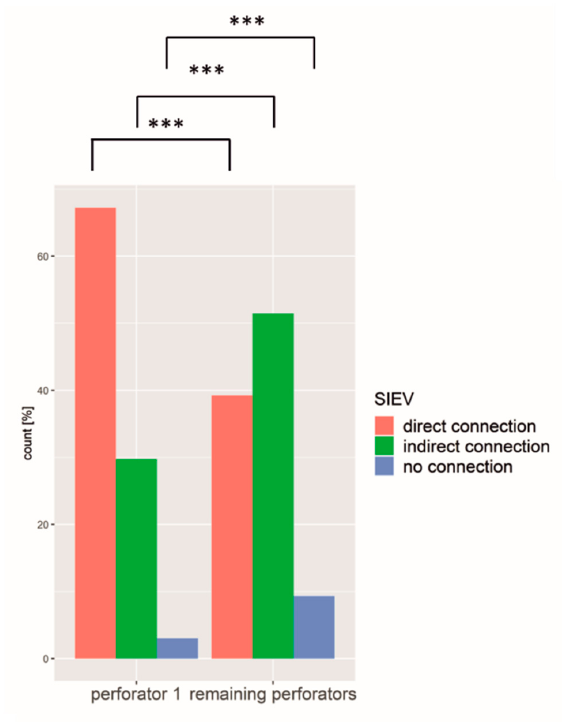
Figure 8. The largest perforator was significantly more often directly connected to the SIEV